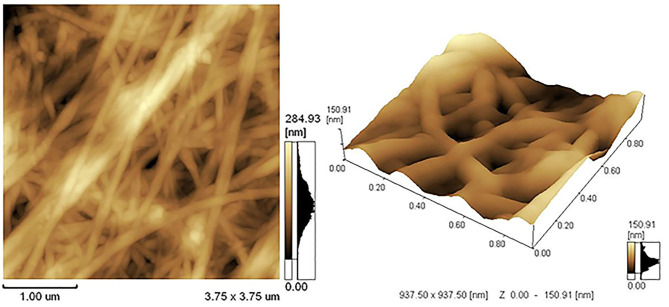
AFM image of the BC.